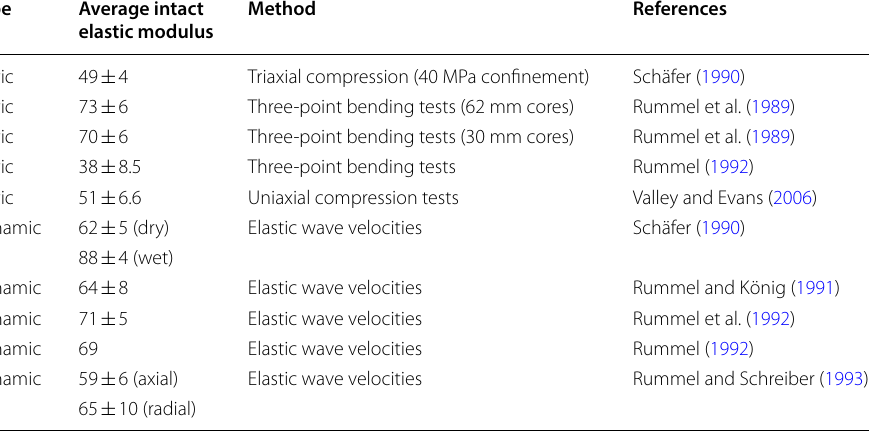
Table 1 Summary of the elastic moduli reported for URG granites from EPS-1 and GPK-1. From (Rummel et al. 1989; Schäfer 1990; Rummel and König 1991; Rummel et al. 1992; Rummel 1992; Rummel and Schreiber 1993; Valley and Evans